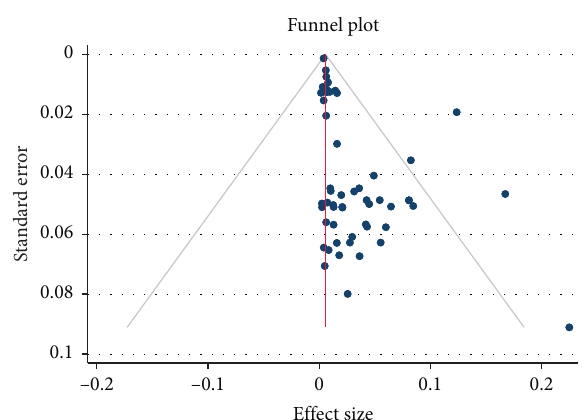
Figure 3: Funnel plot of anti-HCV prevalence in Ethiopia pub- lished from 2010 to 2020.